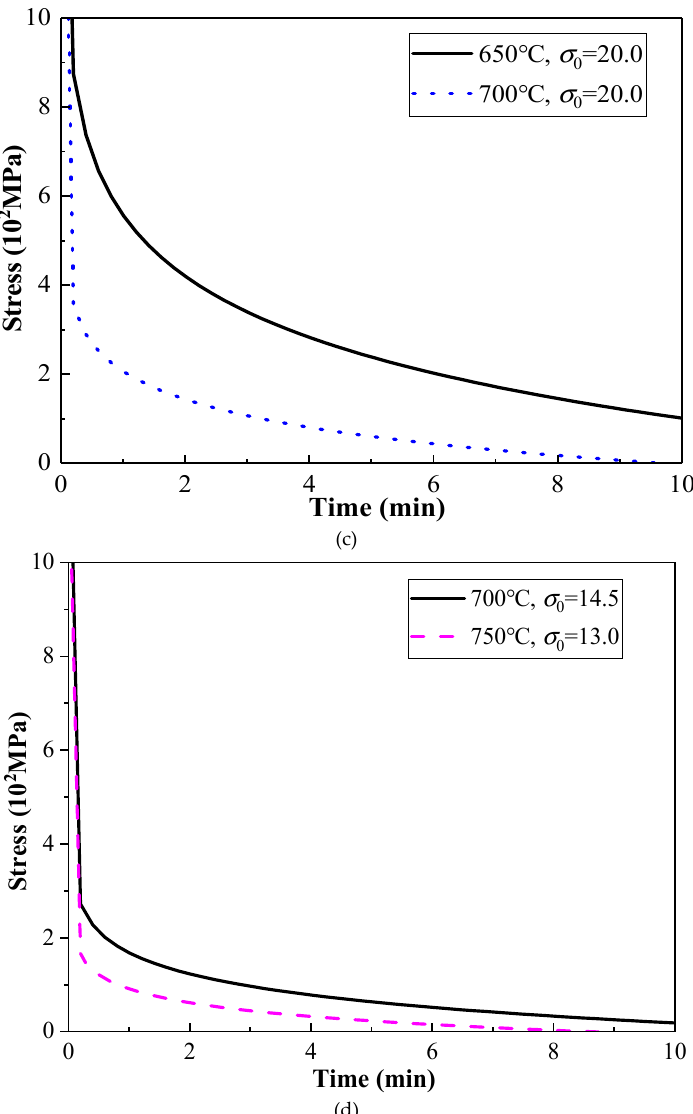
Figure 7. Stress relaxation equations under different temperatures and pressures. ( a ) The stress–strain curve at 650°C; ( b ) the stress–strain curve at 700°C; ( c ) stress–strain curve when σ 0 is about 20 MPa; ( d ) stress–strain curve when σ 0 is about 14 MPa.